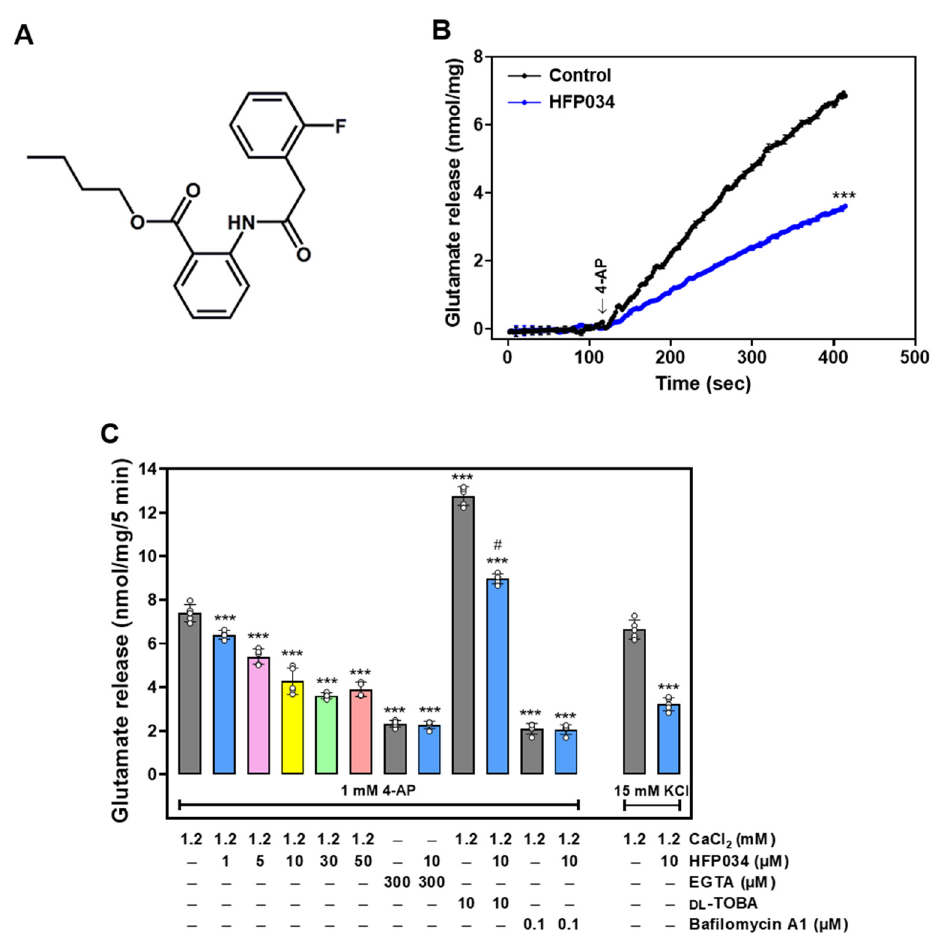
Figure 1. Effect of HFP034 on 4-AP-evoked glutamate release from rat cerebro-cortical nerve terminals. ( A ) The chemical structure of HFP034. ( B ) Glutamate release was measured under control conditions or in the presence of 10 µ M HFP034 added 10 min prior to the addition of 4-AP (1 mM). ( C ) Effect of HFP034 at different concentrations on 4-AP-evoked glutamate release, and extracellular Ca 2+ -free solution, glutamate transporter inhibitor DL -TBOA or vesicular glutamate transporter inhibitor bafilomycin A1 on the effect of HFP034. Effect of HFP034 on the release of glutamate evoked by 15 mM KCl is shown in the Figure 1C. Each dot represents the value for an individual experiment. Data are presented as mean ± S.E.M. ( n = 5 per group). *** p < 0.001 vs. control group; # p < 0.001 vs. DL -TBOA-treated group.